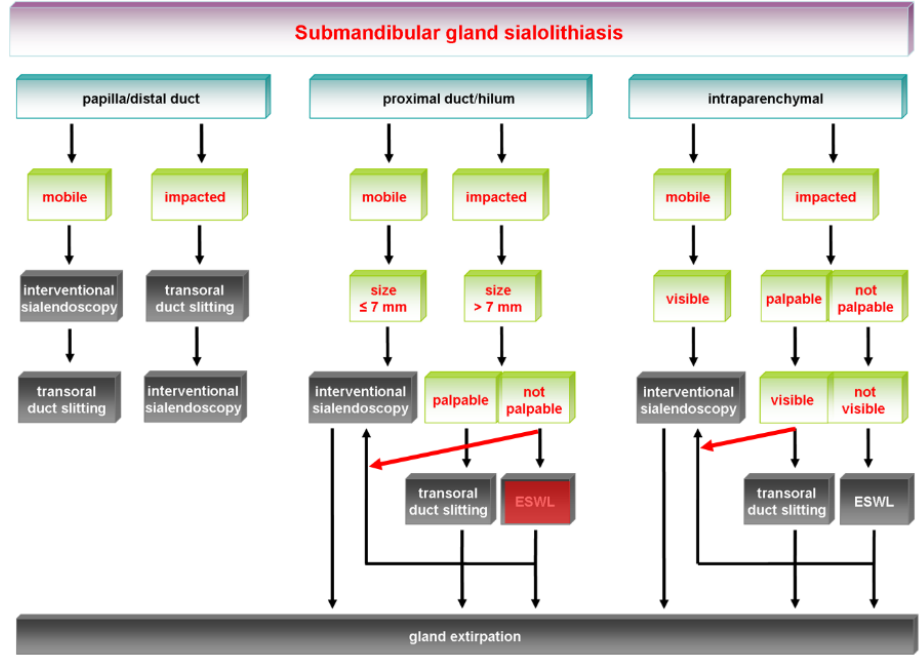
Figure 1. Submandibular gland sialolithiasis: earlier treatment algorithms [26], with changes indi- cated (red-marked boxes, red arrows). ESWL, extracorporeal shock-wave lithotripsy.